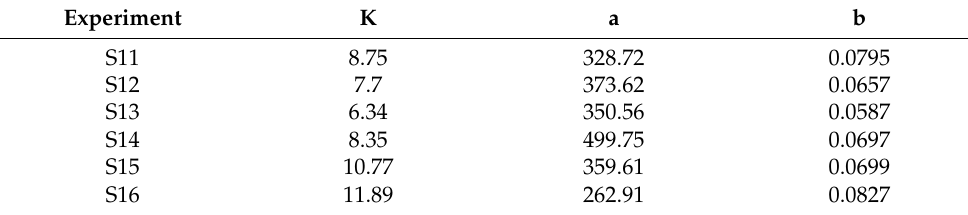
Table 3. Fitting